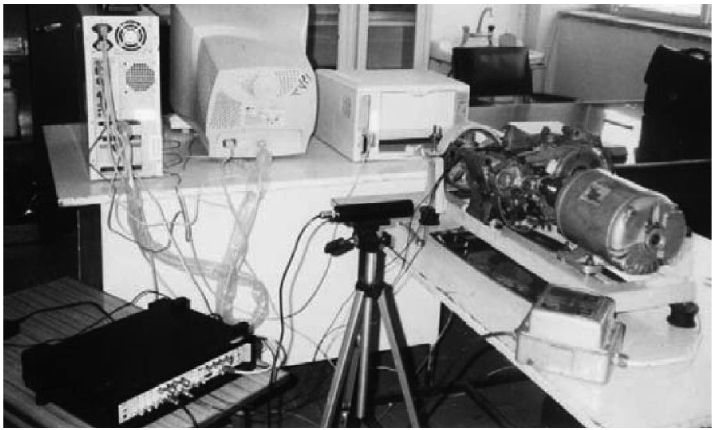
Fig. 5. Test rig and data acquisition system